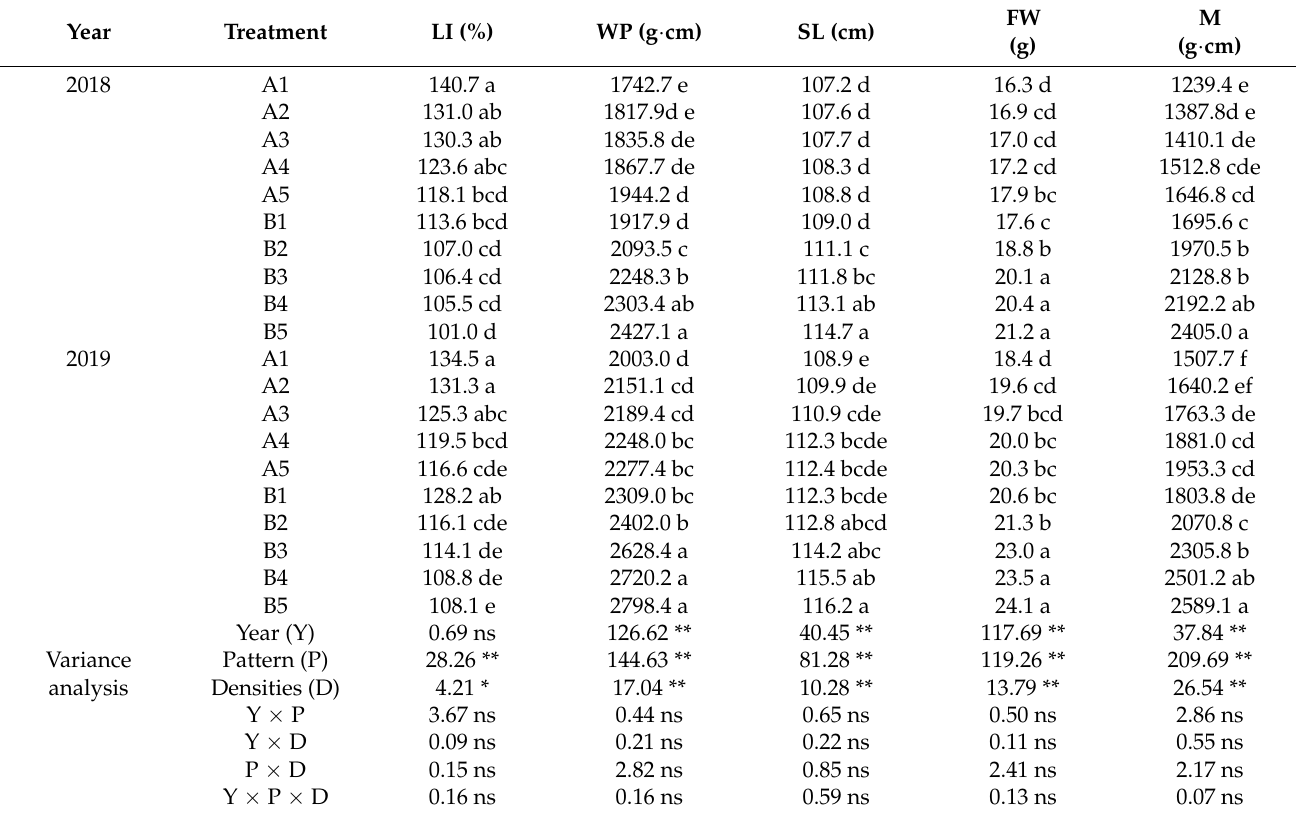
Table 3. Rice lodging index and its stem mechanics parameters as affected by mechanical